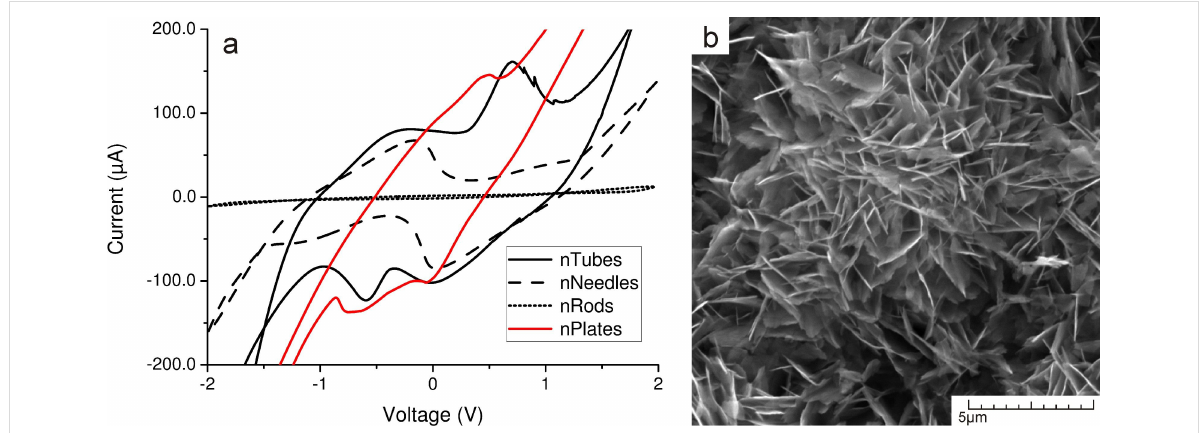
Figure 7: (a) CV curve for the concentration of 1.5 mM Pb(NO 3 ) 2 on ZnO nanoplates (red) compared to the previously used ZnO morphologies (black curves); (b) SEM image of as-synthesized ZnO nanoplates.